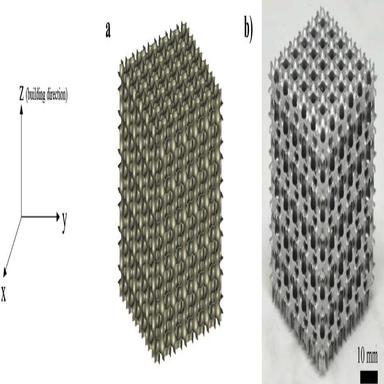
a) CAD model and b) LPBF fabricated 6 � 6 � 6 IWP lattice.